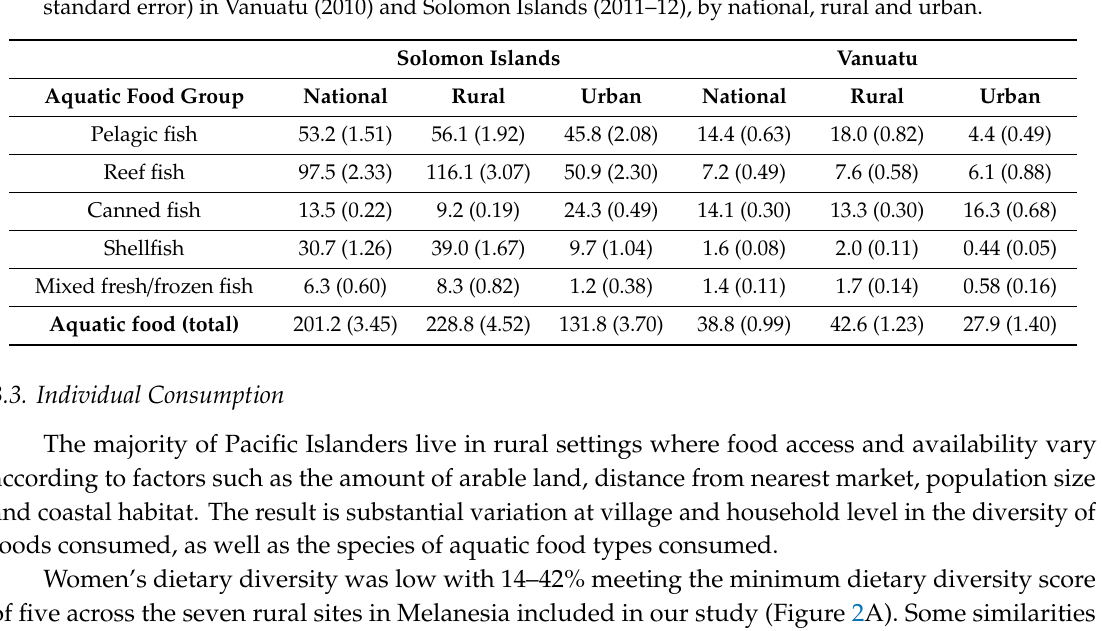
Table 2. Mean daily per capita apparent consumption of aquatic foods (edible portion in grams